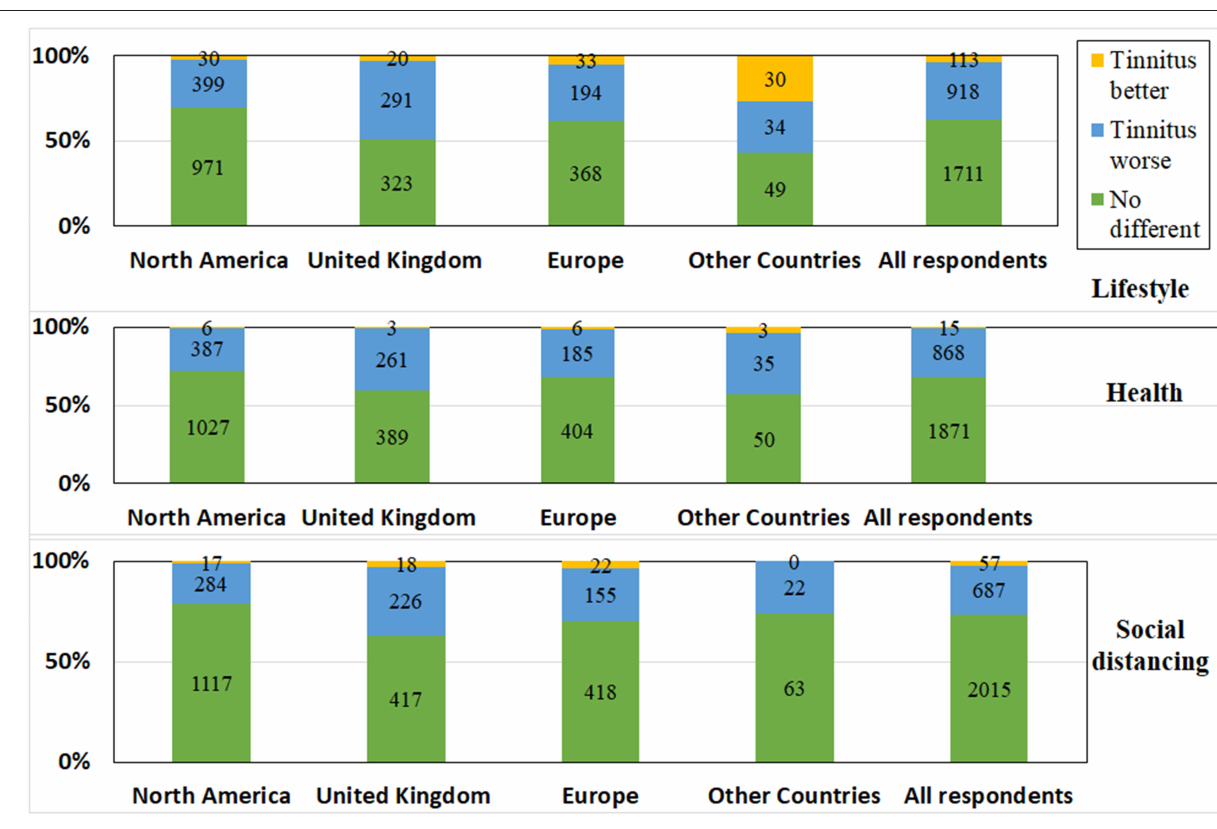
medications affected tinnitus, both prescribed medications e.g., “Steroid medication made my tinnitus worse” (Male, 66 years, USA) and using vitamins to try to boost the